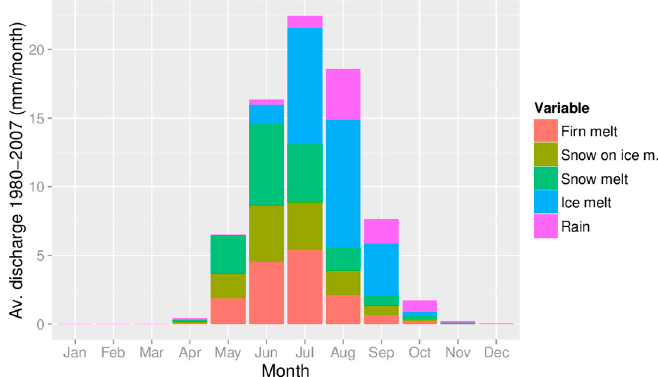
Figure A1. Monthly streamflow contributions at Vernagtbach gauging station.